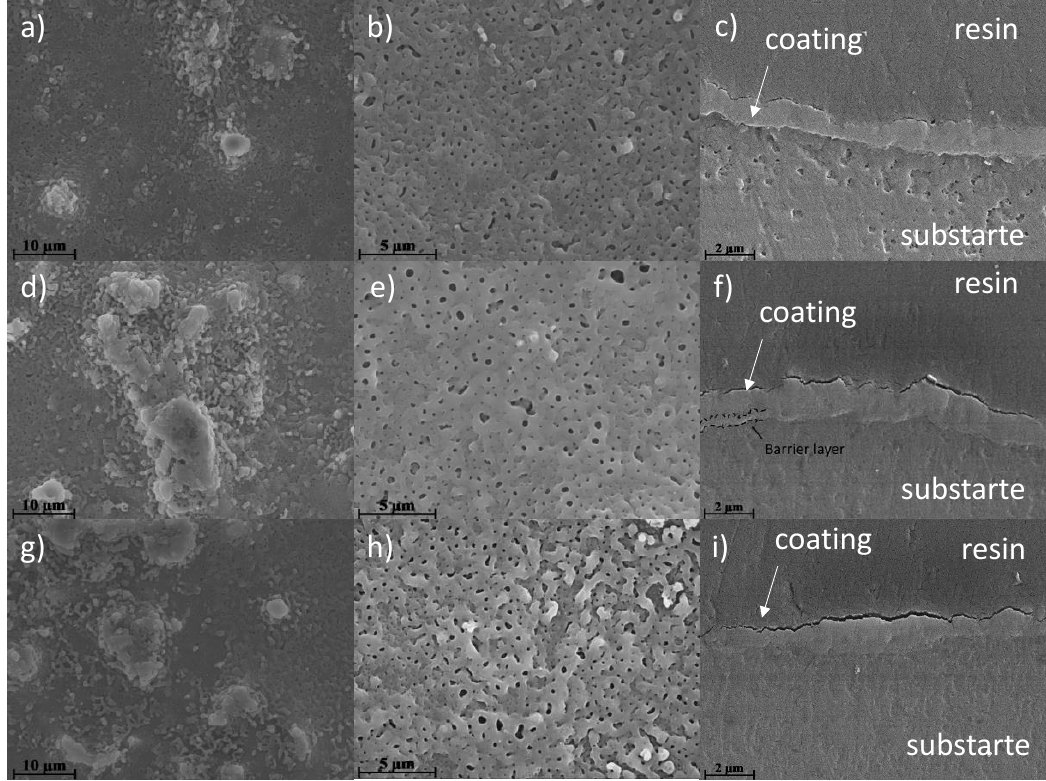
Figure 2. Secondary electron micrographs of the coating plan views ( a,b,d,e,g,h ) and the cross-sections ( c,f,i ): ( a–c ) FPEO; ( d–f ) FPEO_CaO; ( g-i ) FPEO_CaGlyP. ( b,e,h ) are the magnification of flat regions in ( a,d,g ), respectively.